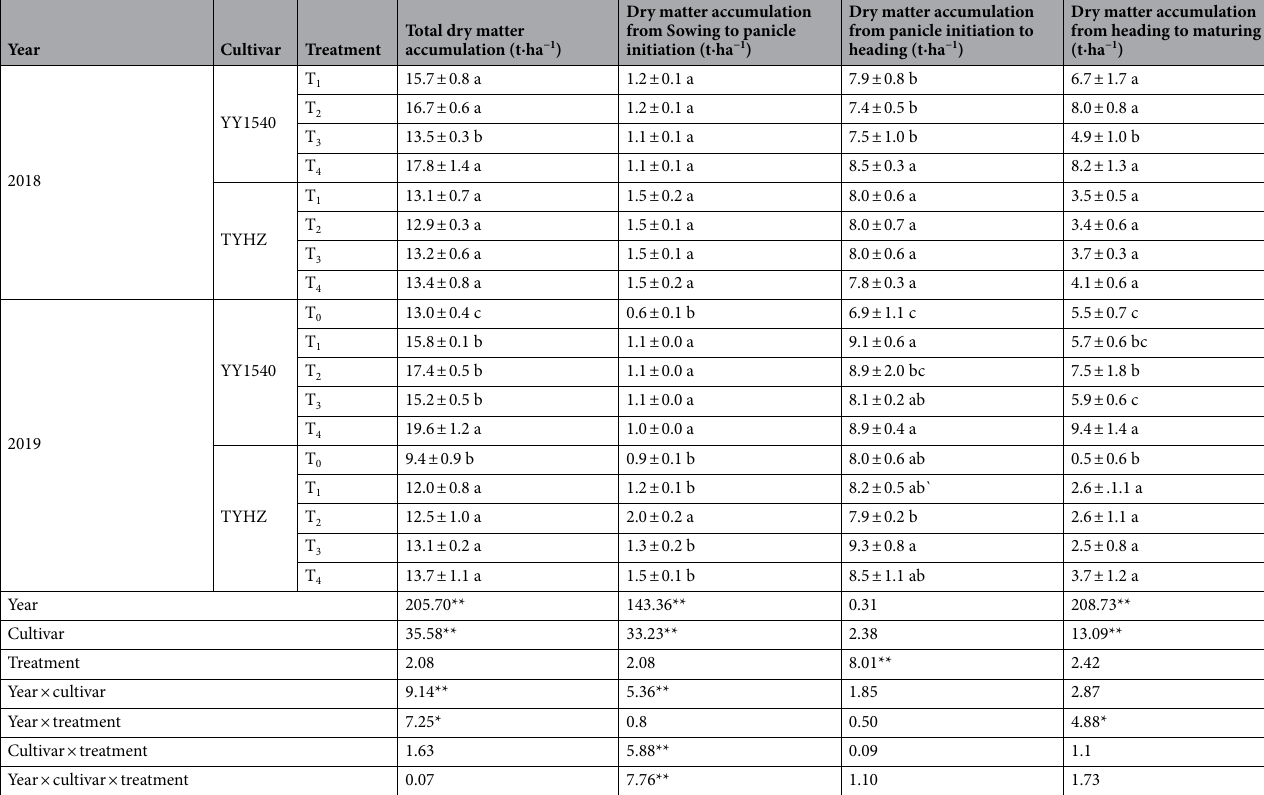
Table 3. Effect of nitrogen fertilization mode on dry matter accumulation by indica – japonica hybrid rice (‘Yongyou1540’, YY1540) and indica hybrid rice (‘Tianyouhuazhan’, TYHZ). Values followed by different lower-case letters within the same column are significantly different among treatments. * p < 0.05; ** p < 0.01.